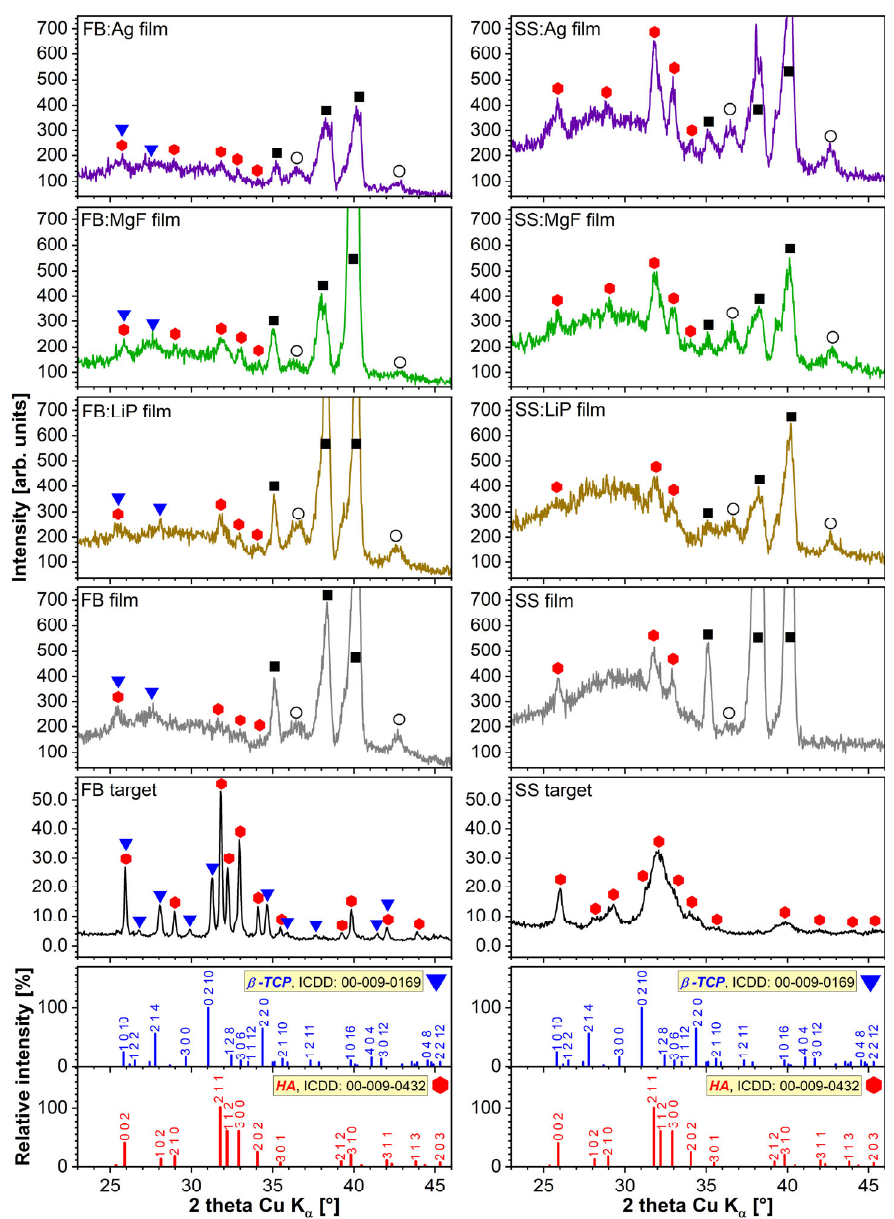
Figure 3. Comparison of the X-ray diffractograms recorded for the FB and SS source target materials (collected in Bragg–Brentano geometry) and of the simple and doped FB and SS thin films (collected in grazing incidence geometry). Symbols: —hydroxyapatite; — β -tricalcium phosphate; —titanium; —TiO).